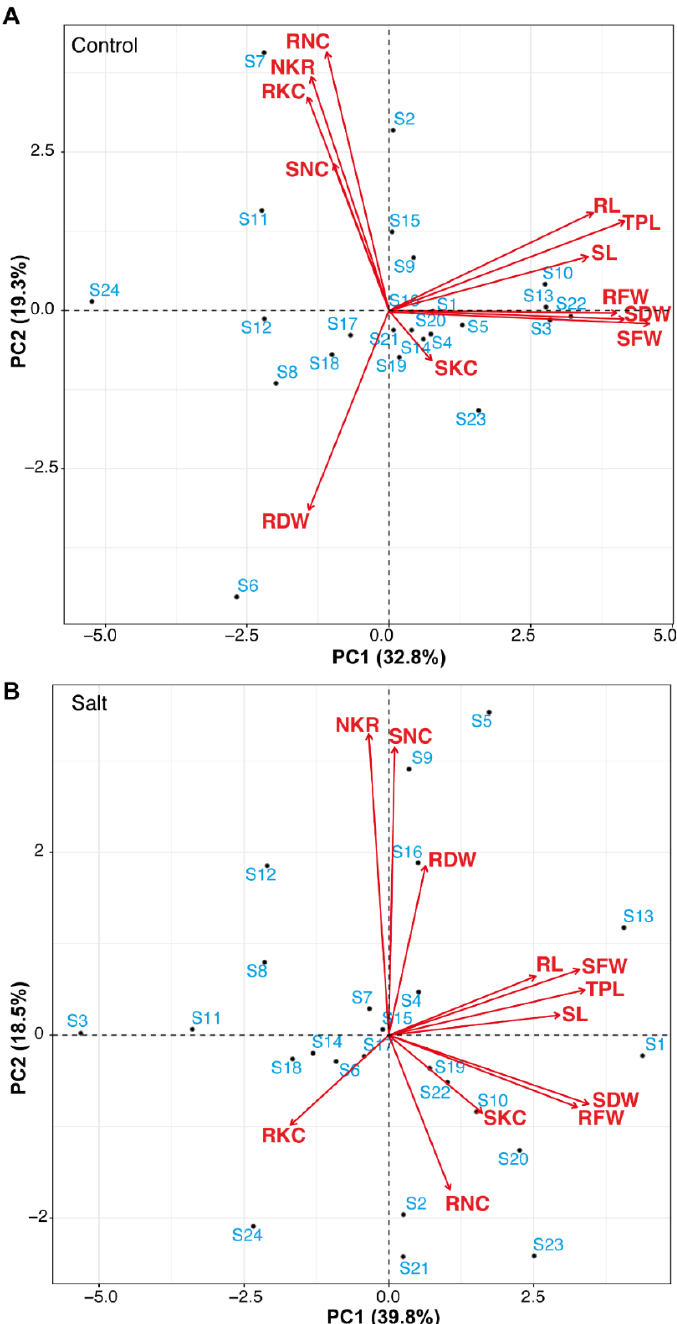
Figure 3. PCA of morpho-physiological traits of rice genotypes. Rice seedlings were evaluated under control ( A ) and 200 mM salt stress ( B ). SL = shoot length (cm); RL = root length (cm); TPL = total plant length (cm); SFW = shoot fresh weight (g); RFW = root fresh weight (g); SDW = shoot dry weight (g); RDW = root dry weight (g); SNC = shoot sodium (Na + ) concentration; SKC = shoot potassium (K + ) concentration; RNC = root Na + concentration; RKC = root K + concentration; NKR = whole plant sodium/potassium (Na + /K + )